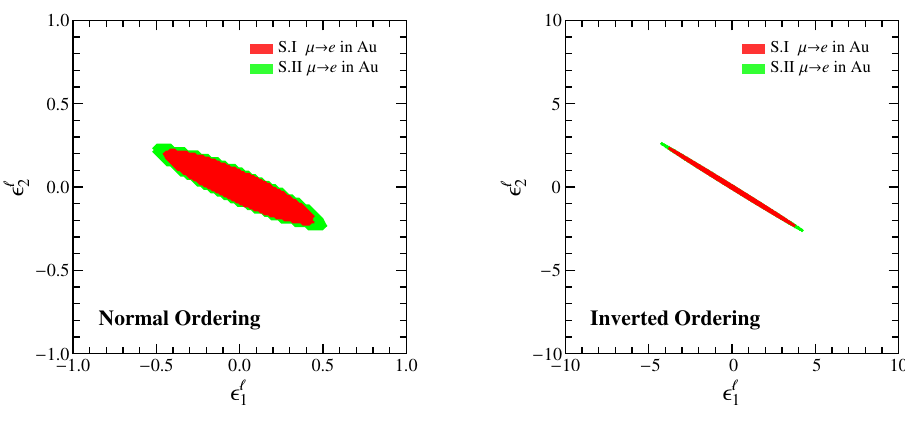
Figure 4 . The same as (cid:12)gure 3, but only under the constraint of (cid:22) ! e conversion in Au.